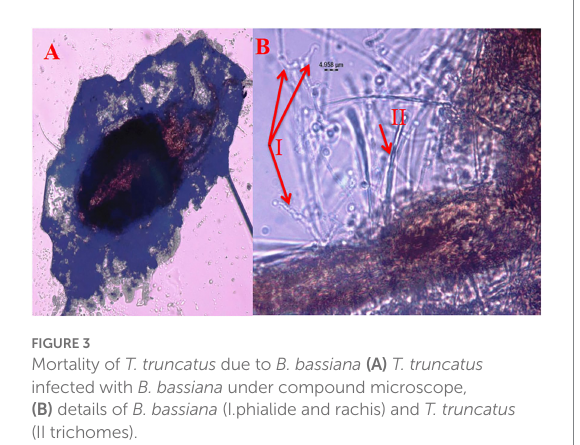
FIGURE 3 Mortality of T. truncatus due to B. bassiana (A) T. truncatus infected with B. bassiana under compound microscope, (B) details of B. bassiana (I.phialide and rachis) and T. truncatus (II trichomes).